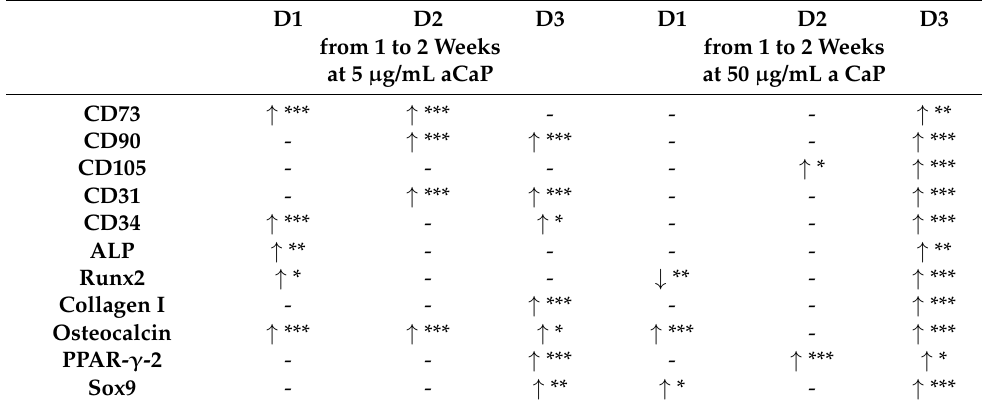
Table 3. Changes in gene expression of ASCs from three Donors (D1–D3) at 2 weeks of